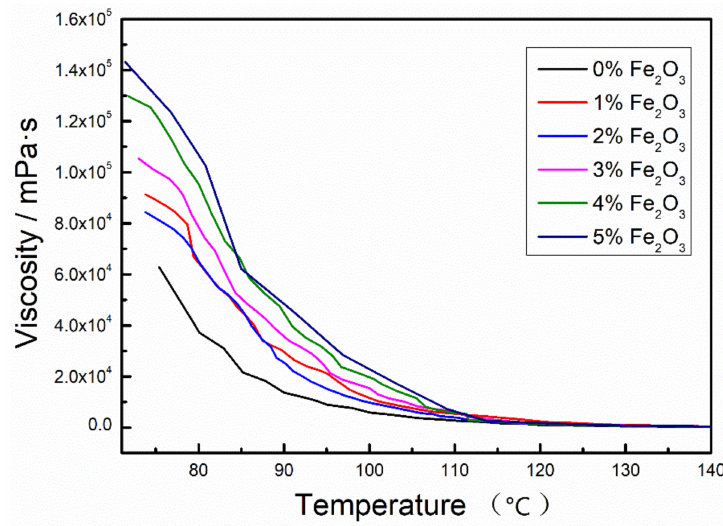
Figure 3. Effect of different Nano-Fe 2 O 3 on asphalt viscosity at different temperatures.